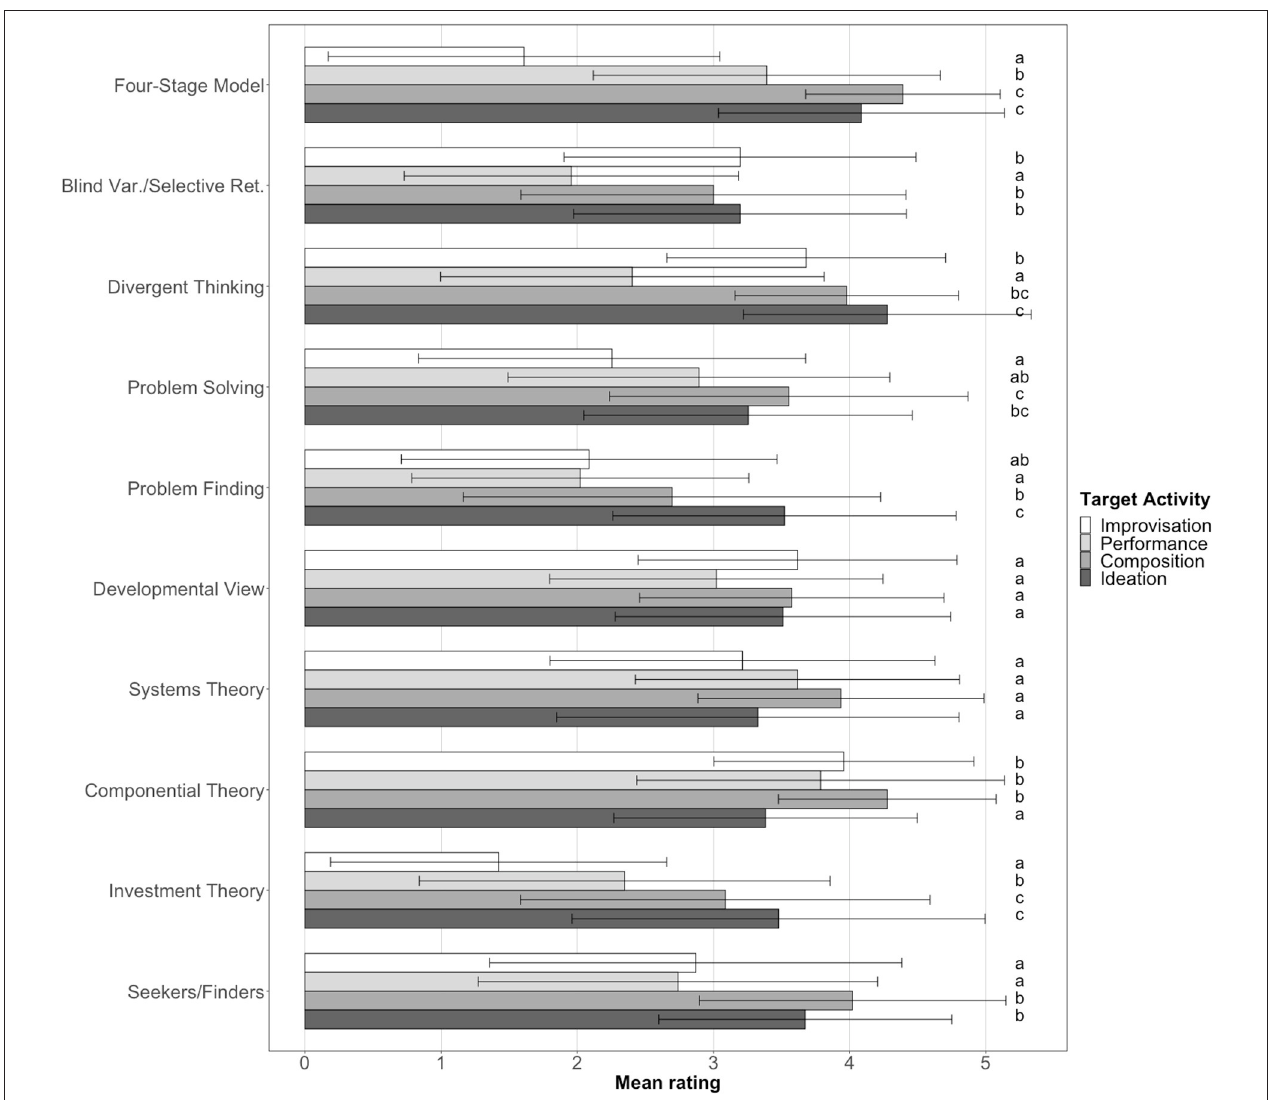
FIGURE 1 | Mean ratings of the 10 theories for the four musical target activities, with standard deviation error bars and compact letter display of pairwise comparisons. Within each theory, activities with the same letter did not differ significantly ( p < 0.05) from one another in their